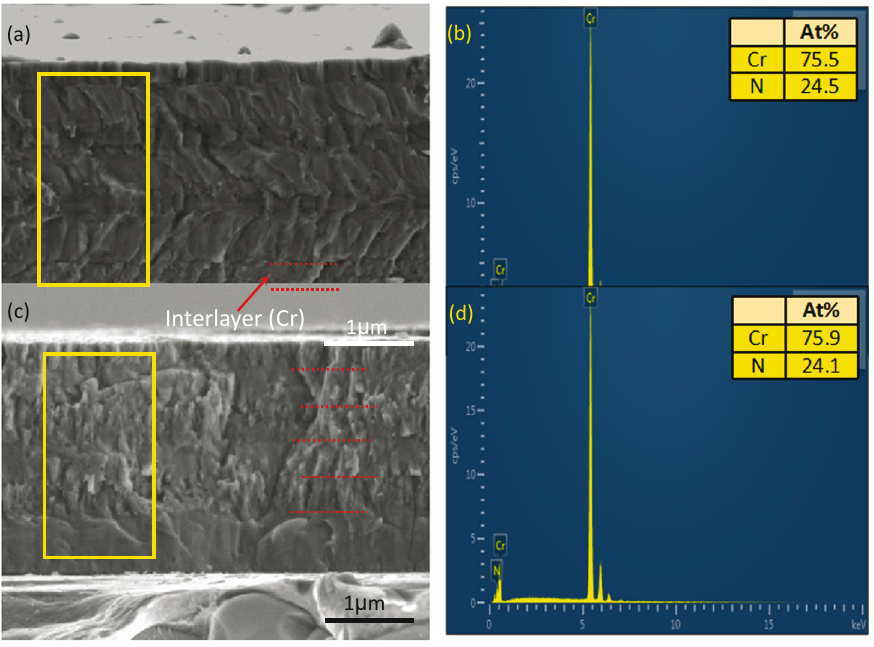
Figure 4: Cross - section morphology and composition structure of coatings A ( a and b ) and B ( c and d ) .